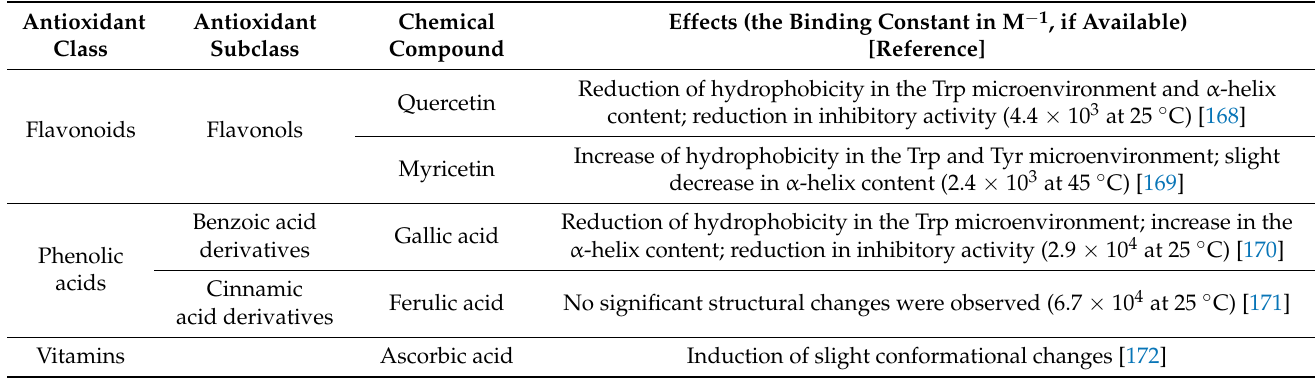
Table 3. Known interactions between food antioxidants and human α